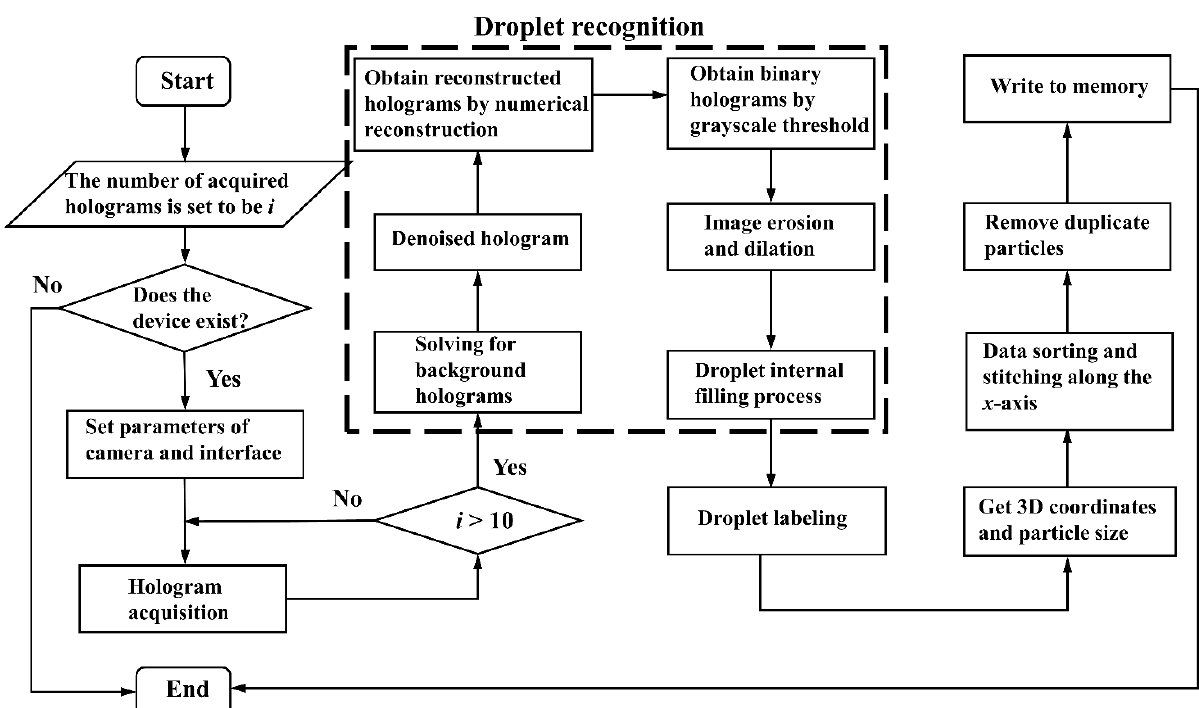
Figure 7. Software processes of real-time reconstruction.